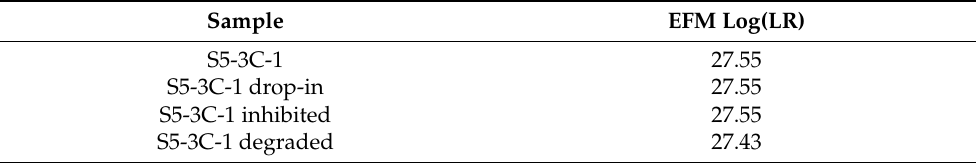
Table 3. DSCS parameters test.